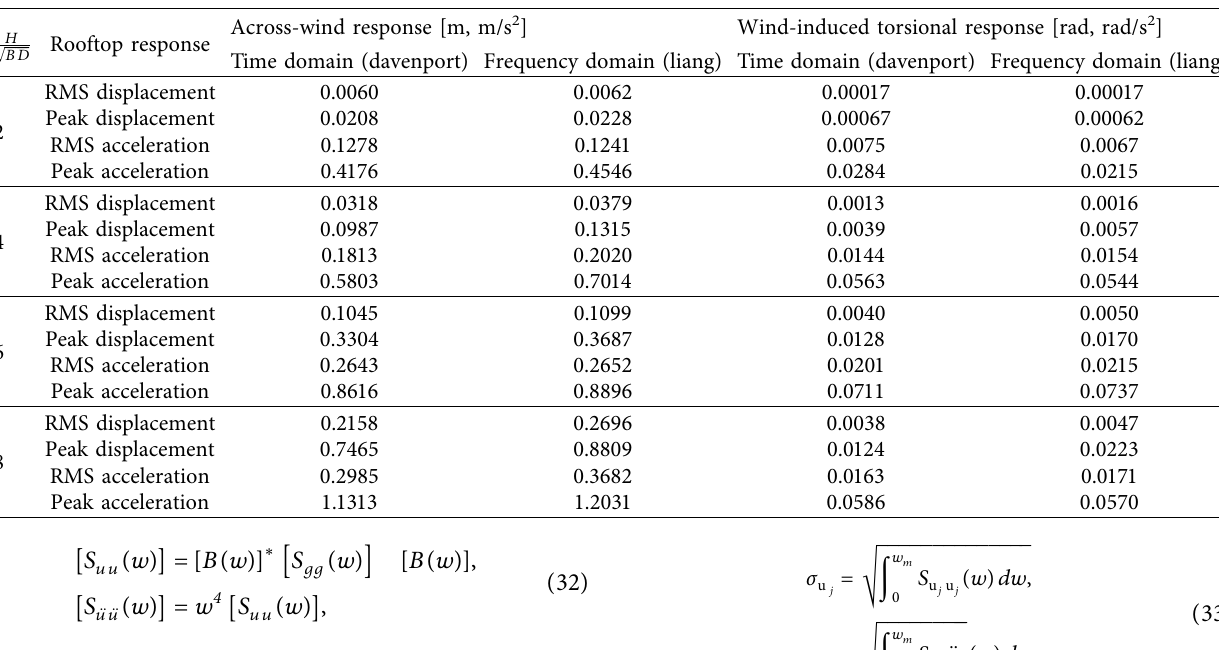
Table 7: Effect of the empirical coherence function on elastic dynamic response of the shear buildings. Across-wind response [m, m/s 2 ] Wind-induced torsional response [rad, rad/s 2 ] H ��� √ Rooftop response BD Time domain (davenport) Frequency domain (liang) Time domain (davenport) Frequency domain